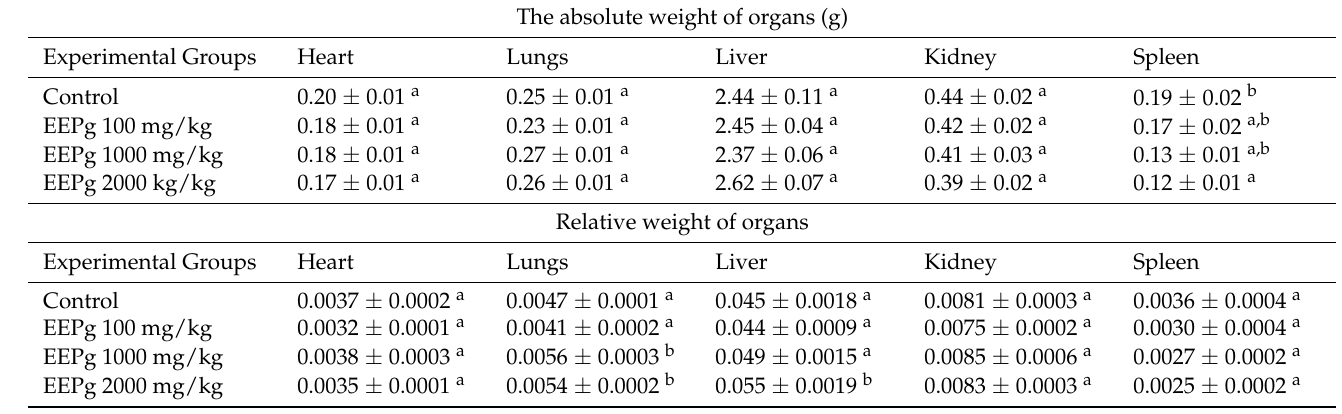
Table 2. Mean values ± standard error of mean absolute and relative weights of the organs of females treated with the ethanolic extract of P. glabratum (EEPg).